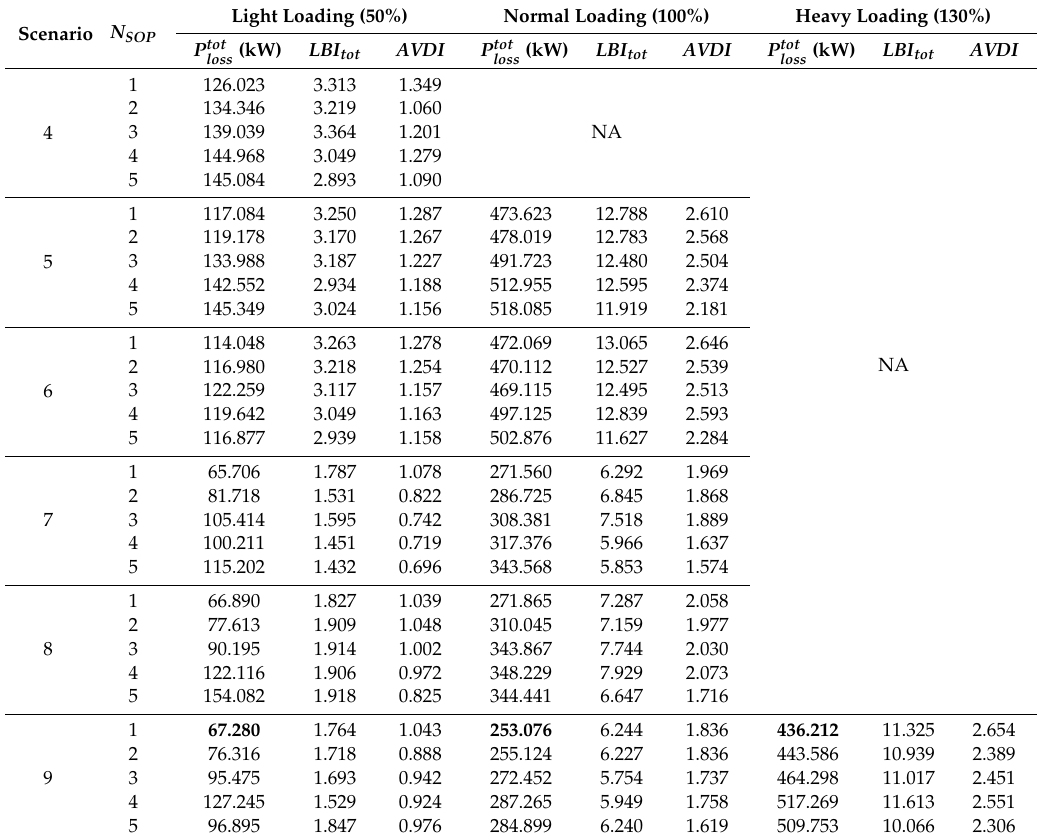
Table 7. Total power losses and PQ indices for scenarios 4 to 9 with SOP losses considered: 83-node